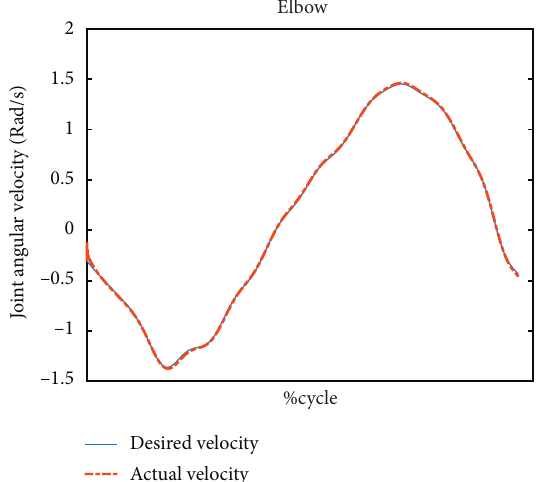
Figure 6: The desired and actual angular velocity of the elbow.